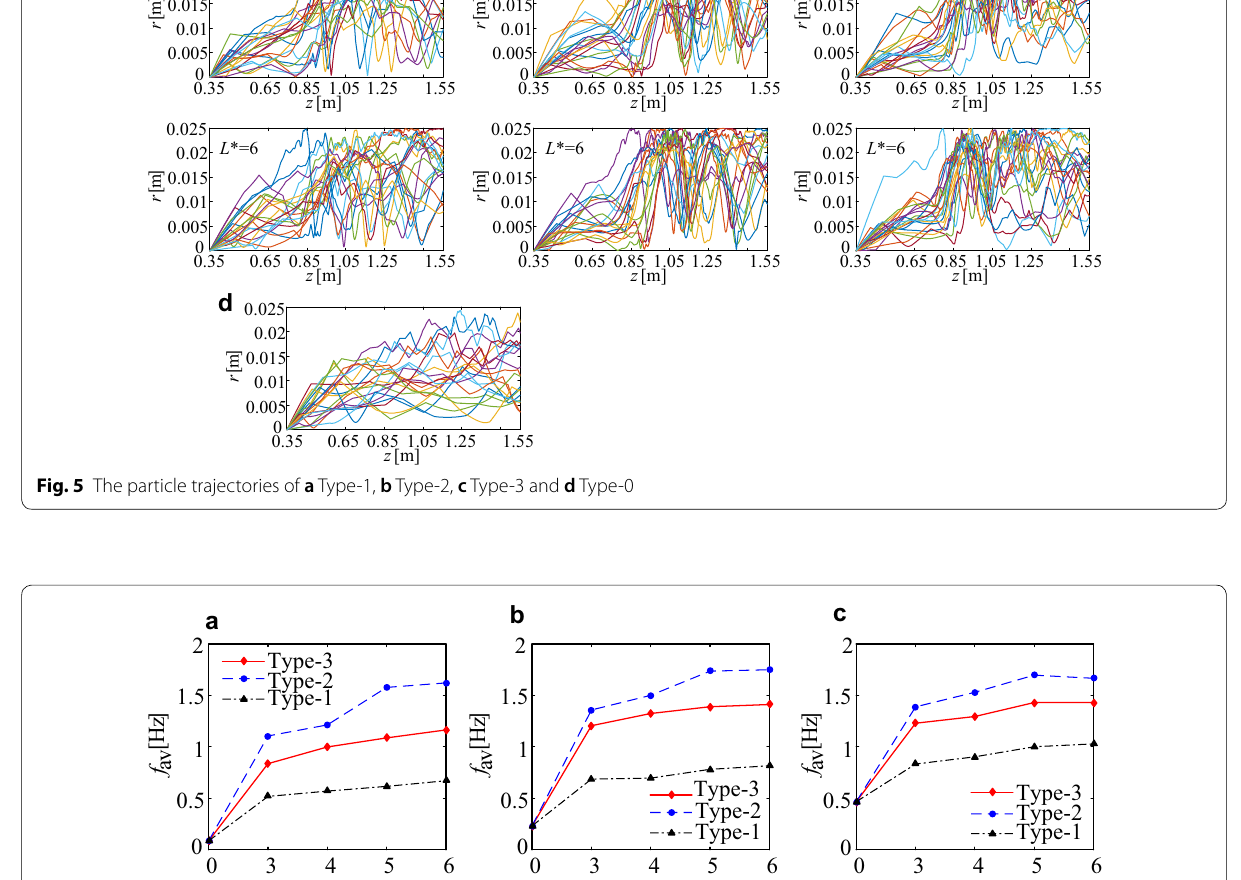
0 represents the PBR without ribs, i.e., the smooth PBR, which =